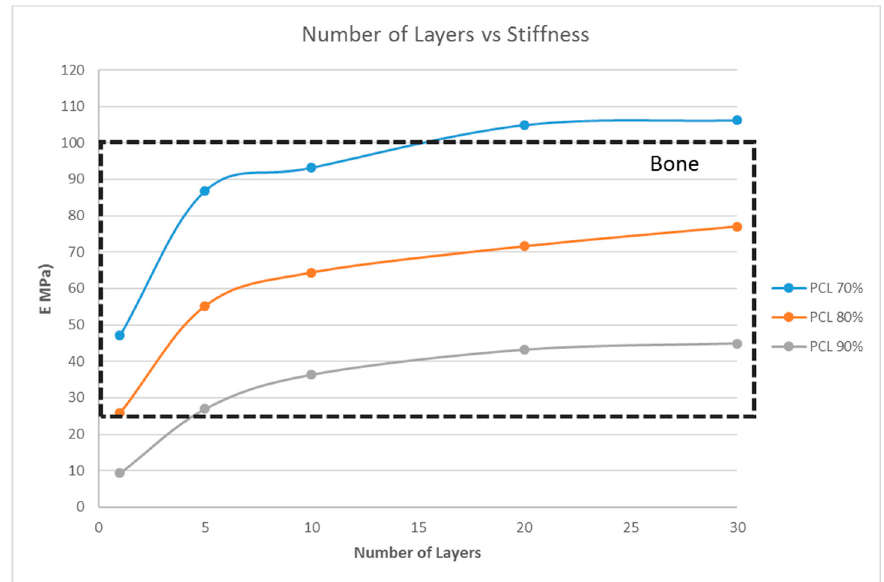
Figure 8. Effect of the number of layers on the stiffness of the structure with a fixed unit cell pore side length ( p = 200 μ m) at three different porosity values (70%, 80%, 90%) for PCL.